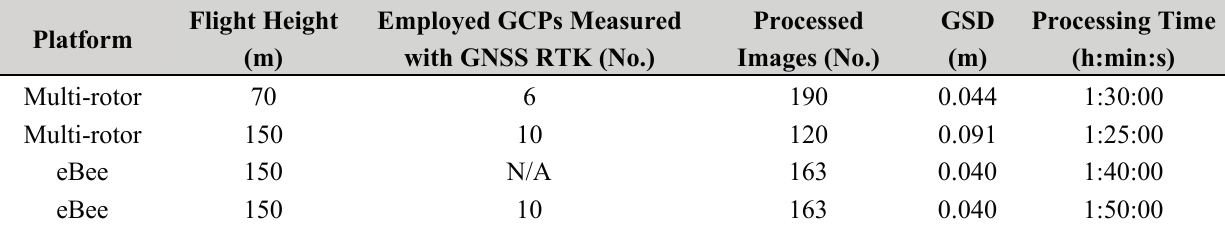
Table 6. Main settings of the off-line image processing